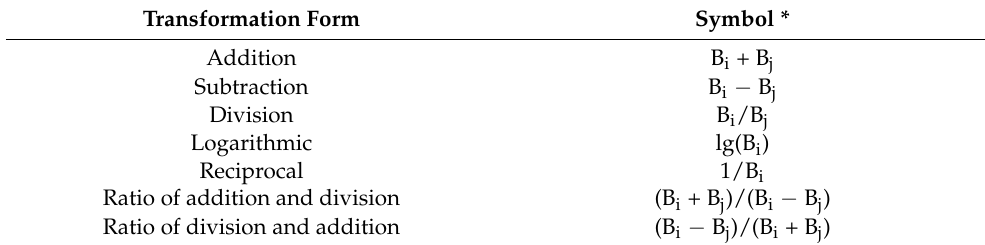
Table 3. Mathematical transformations of fitted multispectral